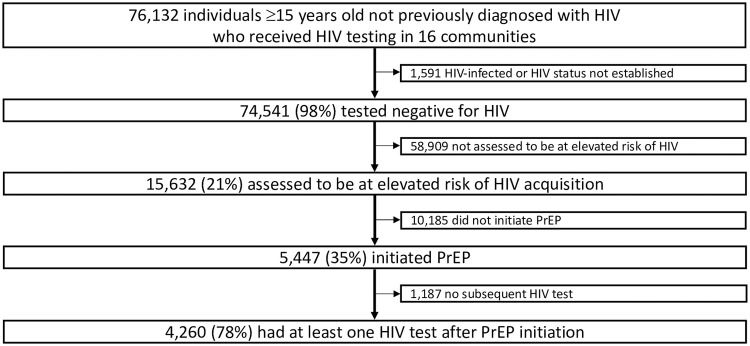
PrEP uptake following population-level HIV testing in 16 communities in rural Kenya and Uganda.Individuals assessed to be at elevated risk of HIV acquisition (based on serodifferent partnership, HIV risk score, or otherwise self-identified HIV risk) were offered enhanced individual counseling on PrEP. Individuals neither in serodifferent partnerships nor identified by the risk score could self-identify as at risk of HIV acquisition. PrEP, pre-exposure prophylaxis.